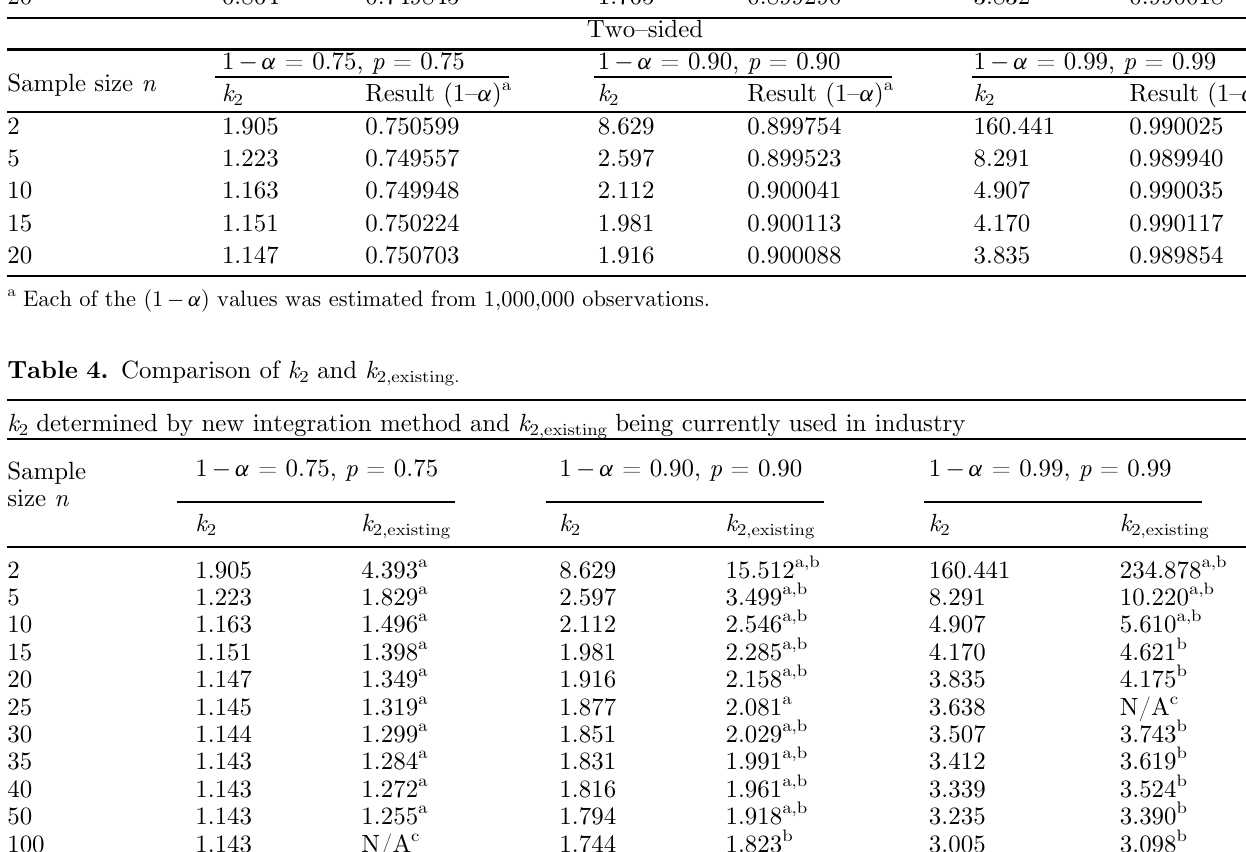
Table 3. Simulation result.